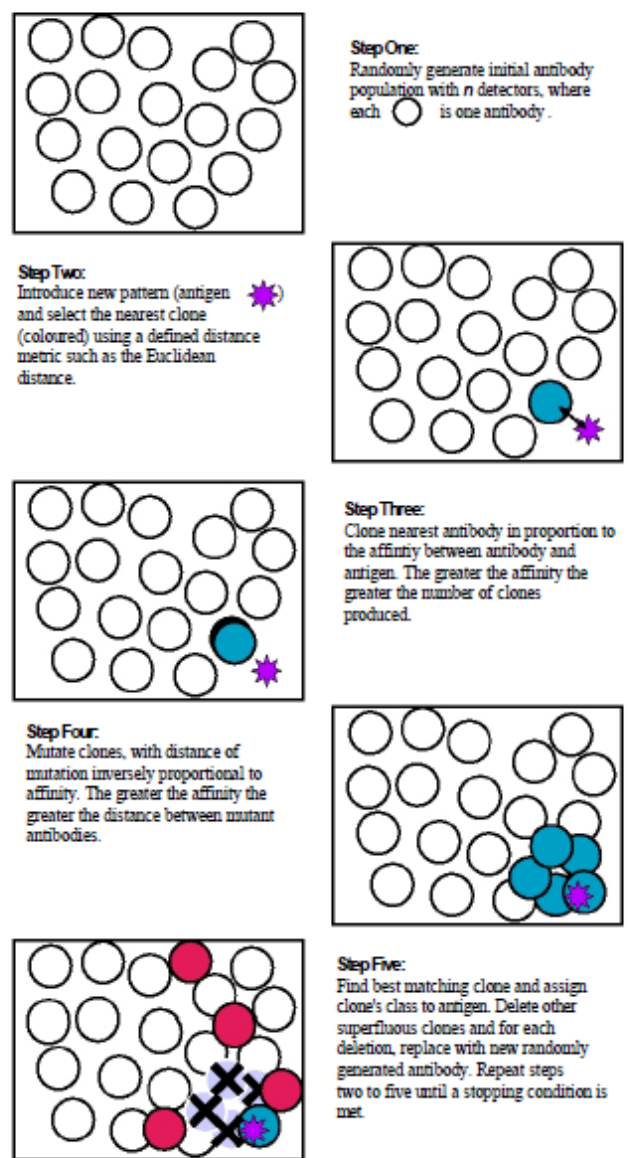
Fig. 1. Clonal selection